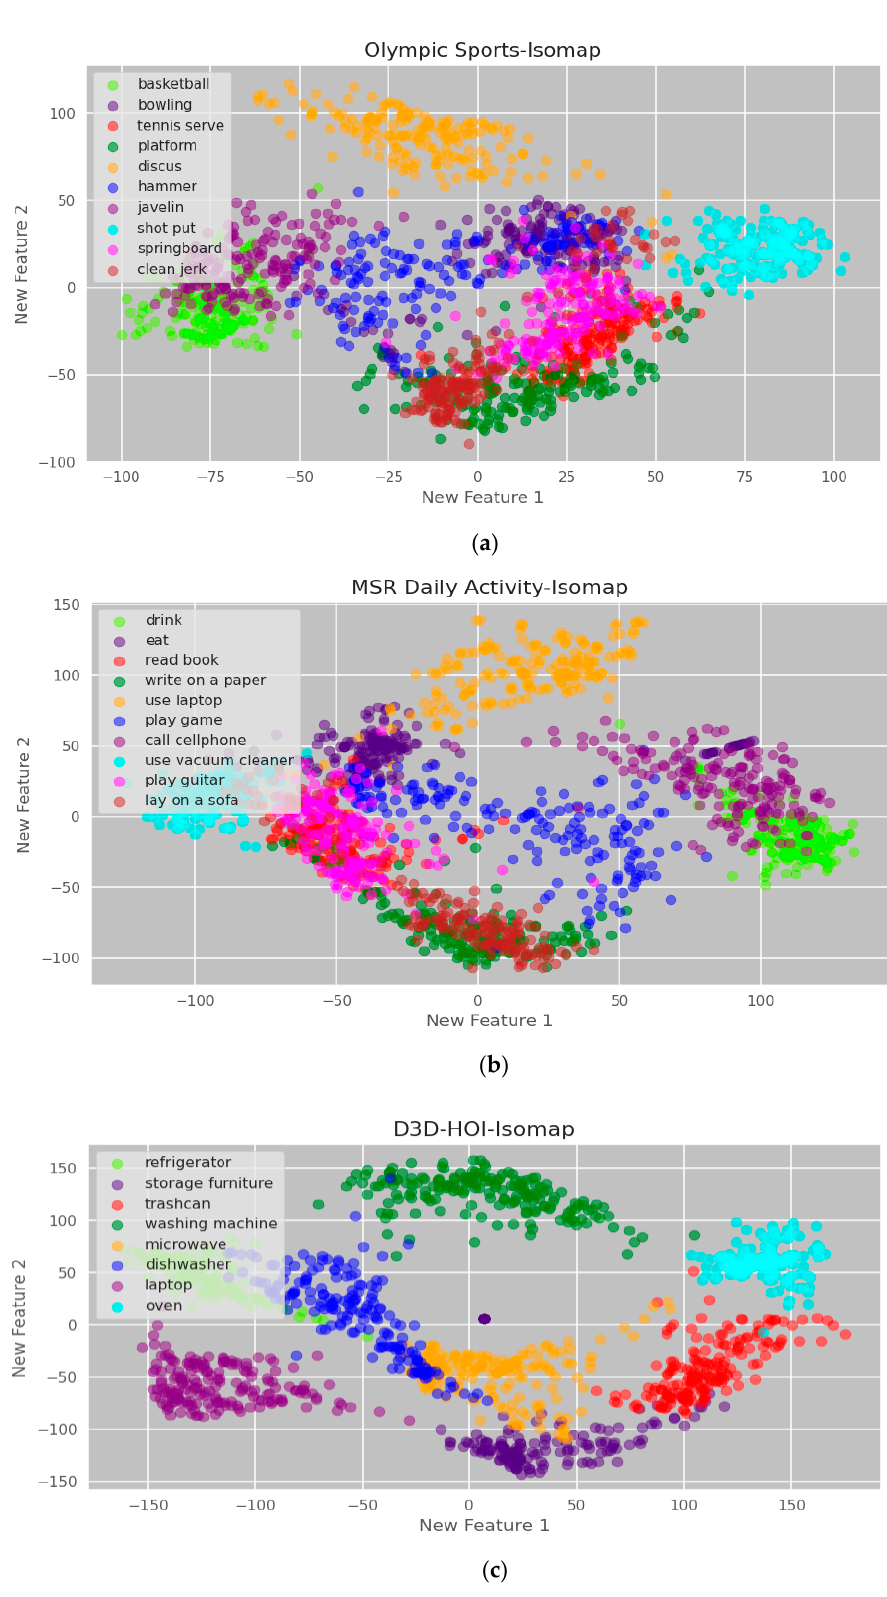
Figure 11. Isomaps of different datasets. ( a ) Olympics Sports, ( b ) MSR Daily Activity 3D, ( c ) D3D-HOI.